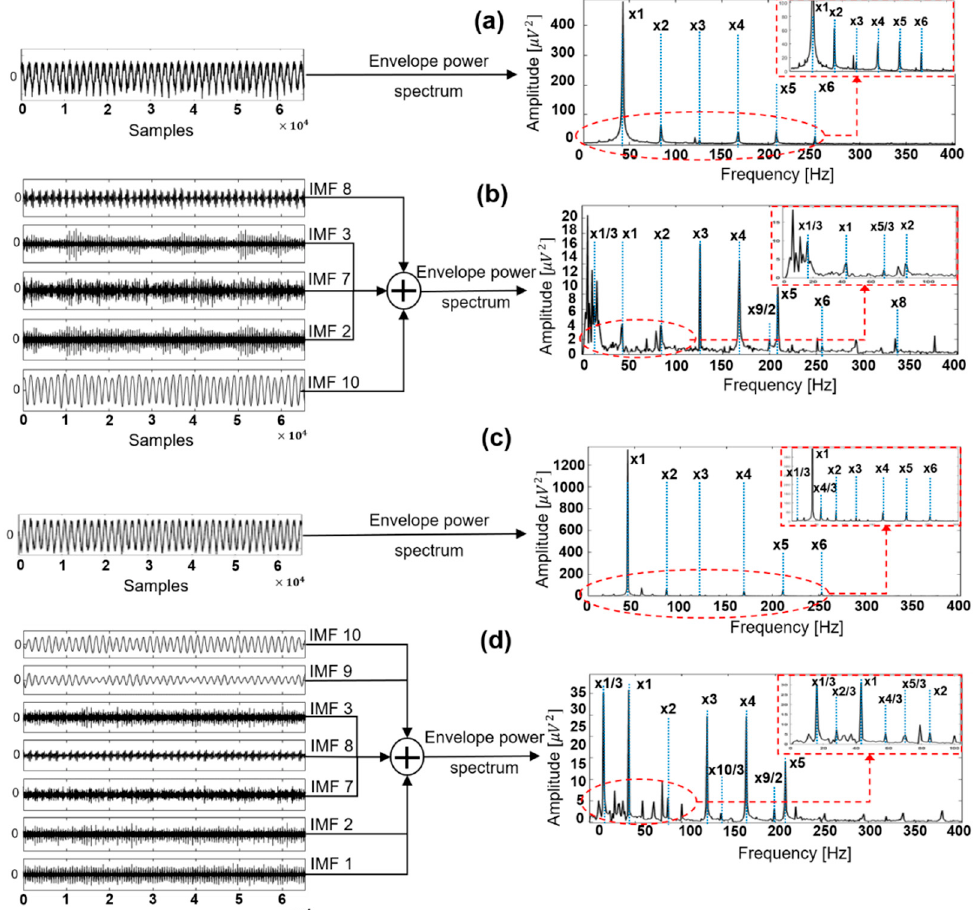
Figure 6. Envelope power spectra of ( a ) class ‘0 g’ original signal; ( b ) reconstructed signal using selected IMFs for class ‘0 g’; ( c ) class ‘2.8 g’ original signal; and ( d ) reconstructed signal using selected IMFs for class ‘2.8 g’.